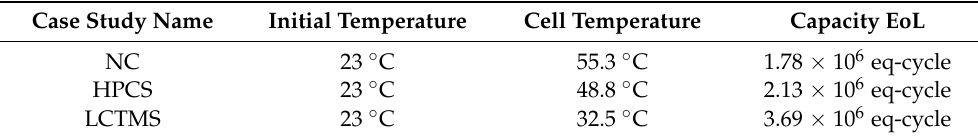
Table 6. Cycle aging end of life estimation for three case studies.